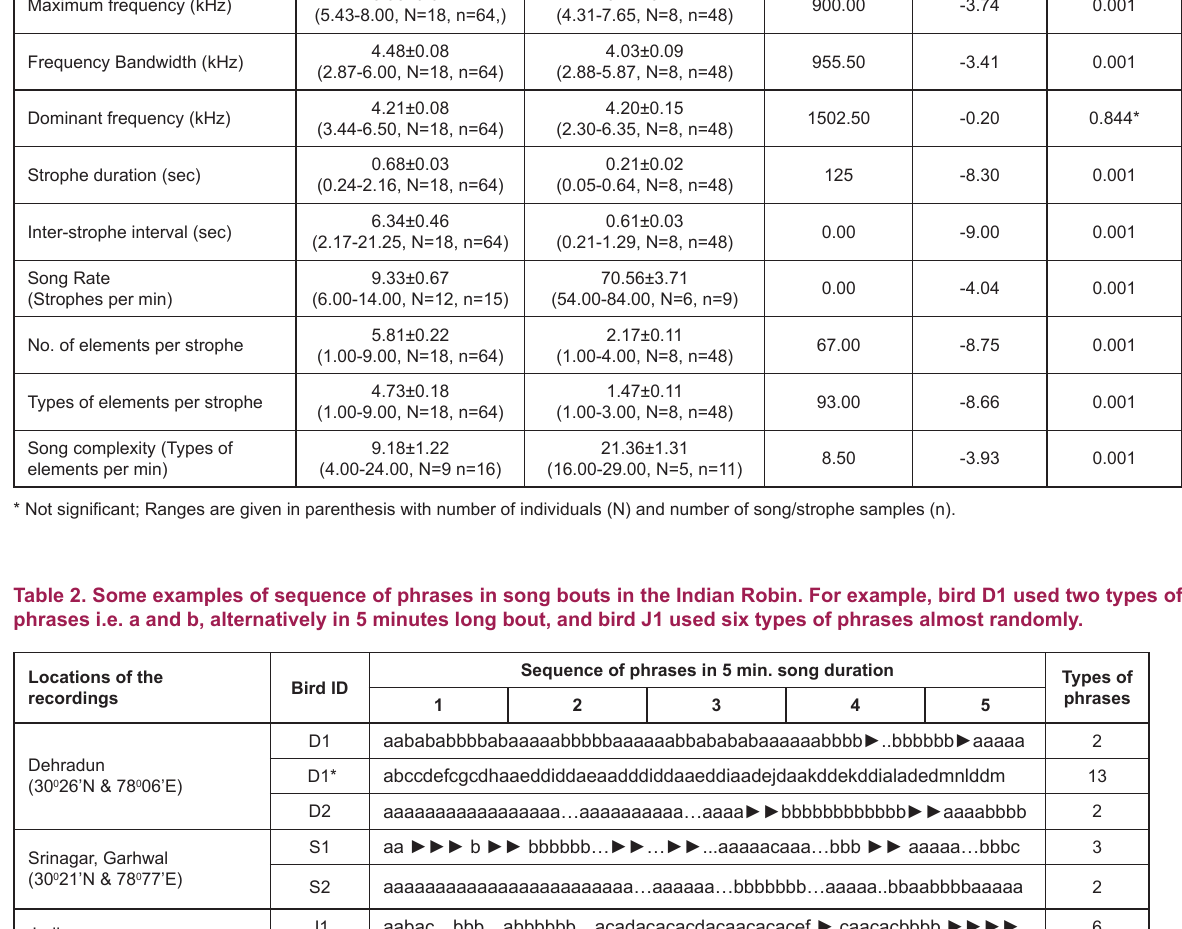
► Whistle; … Longer intervals; * Song type-B (given time duration is not actual)